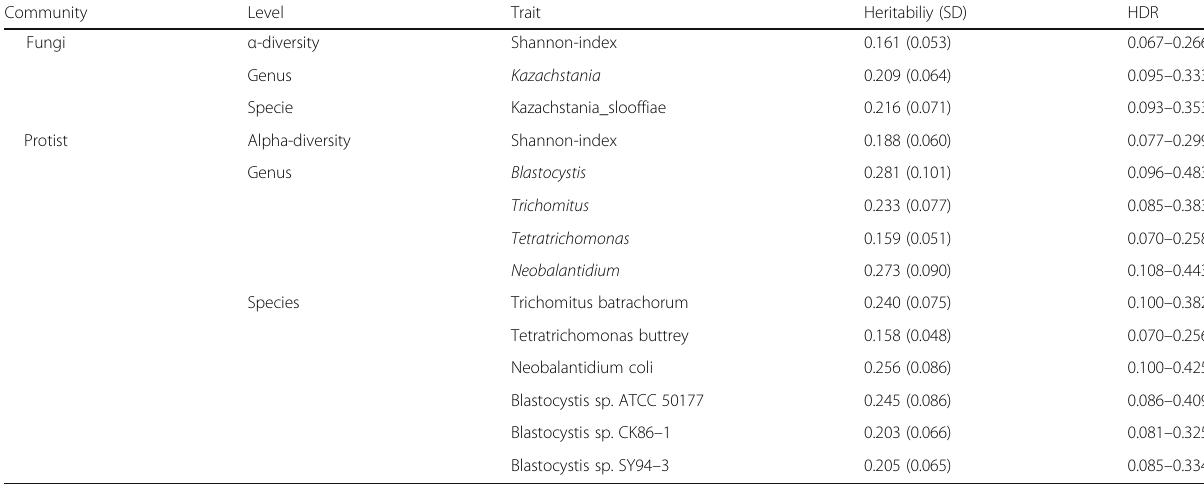
Table 2 Mean (standard deviation) and highest density regions at 95% of marginal posterior distributions for heritabilities of pig gut eukaryotes microbial traits Community